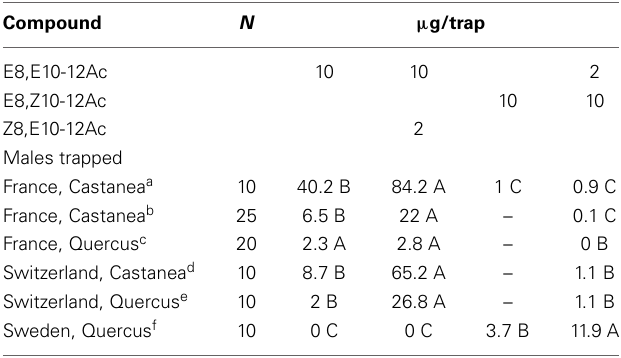
Table 5 | Field attraction of C. splendana males to synthetic pheromone blends in Southern France, Switzerland, and